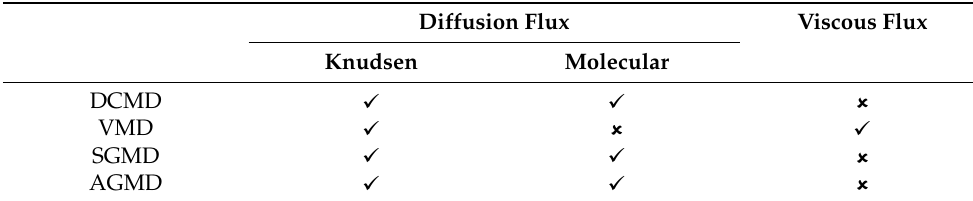
Table 1. Mass transfer mechanism in MDs.